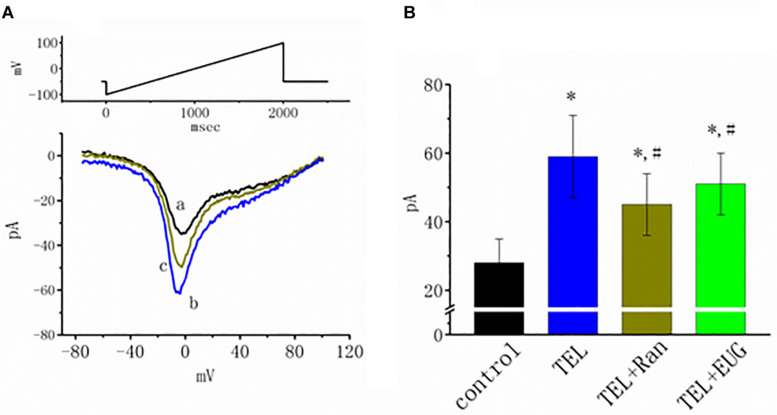
Effects of telmisartan (TEL), TEL plus ranolazine (Ran), or TEL plus eugenol (EUG) on non-inactivating INa [INa(NI)] in mHippoE-14 neurons. Each cell was voltage-clamped at −50 mV, and a 2-s long ramp pulse from −100 to +100 mV (indicated in the upper part of A) was applied at a rate of 0.05 Hz. (A) Original INa(NI) traces responding to the ramp pulse were obtained in the absence and presence of TEL and TEL plus Ran. a: control; b: TEL (3 μM); c: Tel (3 μM) plus Ran (10 μM). (B) Summary of the data demonstrating effects of TEL (3 μM), TEL (3 μM) plus Ran (10 μM), or TEL (3 μM) plus EUG (10 μM) on the peak amplitude of INa(NI) (mean ± SEM; n = 10–12 for each bar). *Significantly different from control (p < 0.05) and #significantly different from the TEL (3 μM)-alone group (p < 0.05). It should be noted that either Ran or EUG can significantly reverse TEL-induced increases in the INa(NI) amplitude.